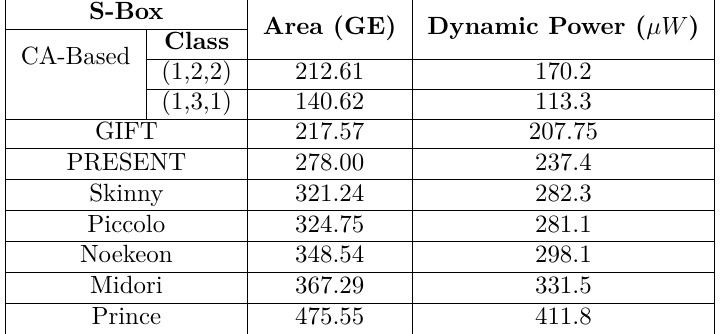
Table 4: Hardware overhead of highly optimized composite TI of CA-Based S-Boxes and Comparison with popular